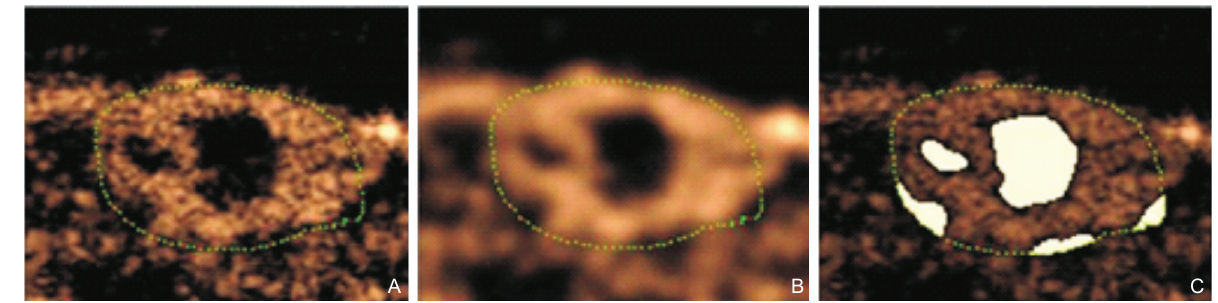
Figure 11 Molecular ultrasound imaging with VEGF targeted microbubbles detected response of anti-angiogenic therapy in mice with clear-cell cancer. Method for obtaining anechoic regions in a peak intensity image (A). The green dots outline the tumor. The image is blurred using a Gaussian filter to eliminate dark areas in speckle (B). The regions below a predetermined intensity threshold are selected as anechoic (C). Note: these are single frames in a 3D volume, so the process will be performed for each slice in the volume. (Reprinted with permission from reference [64])